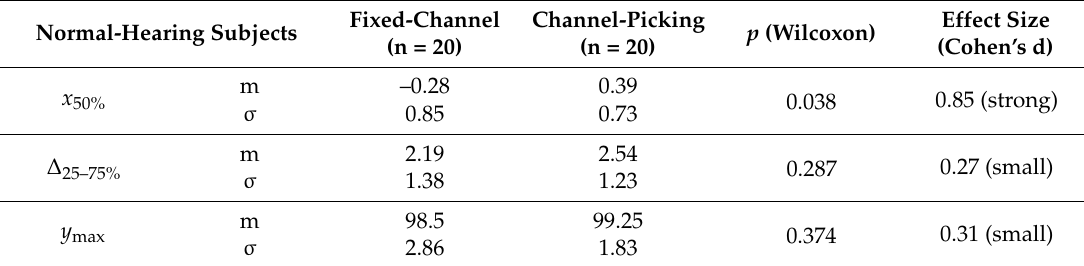
Table 3. Comparison of the sigmoid parameters, for normal-hearing listeners.